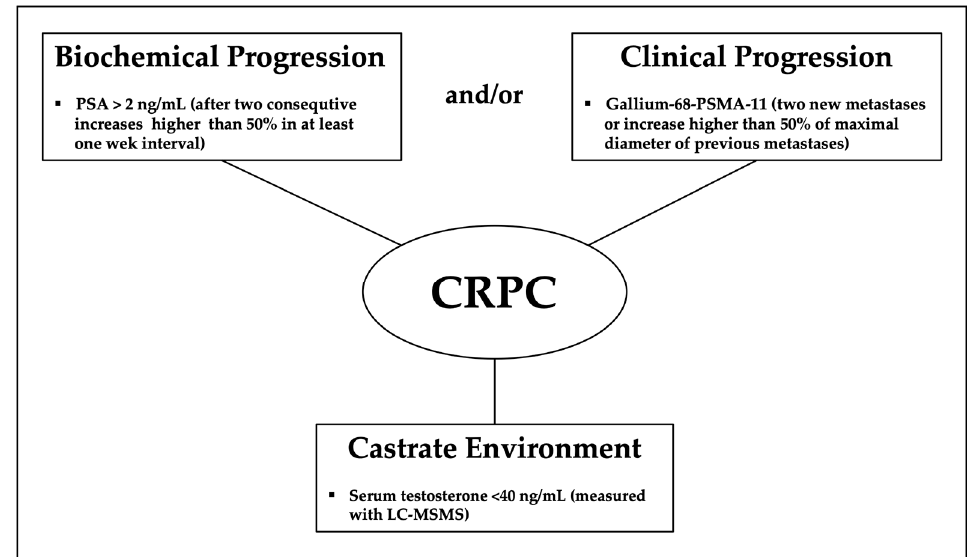
Figure 2. Proposed definition of Castrate Resistant Prostate Cancer.